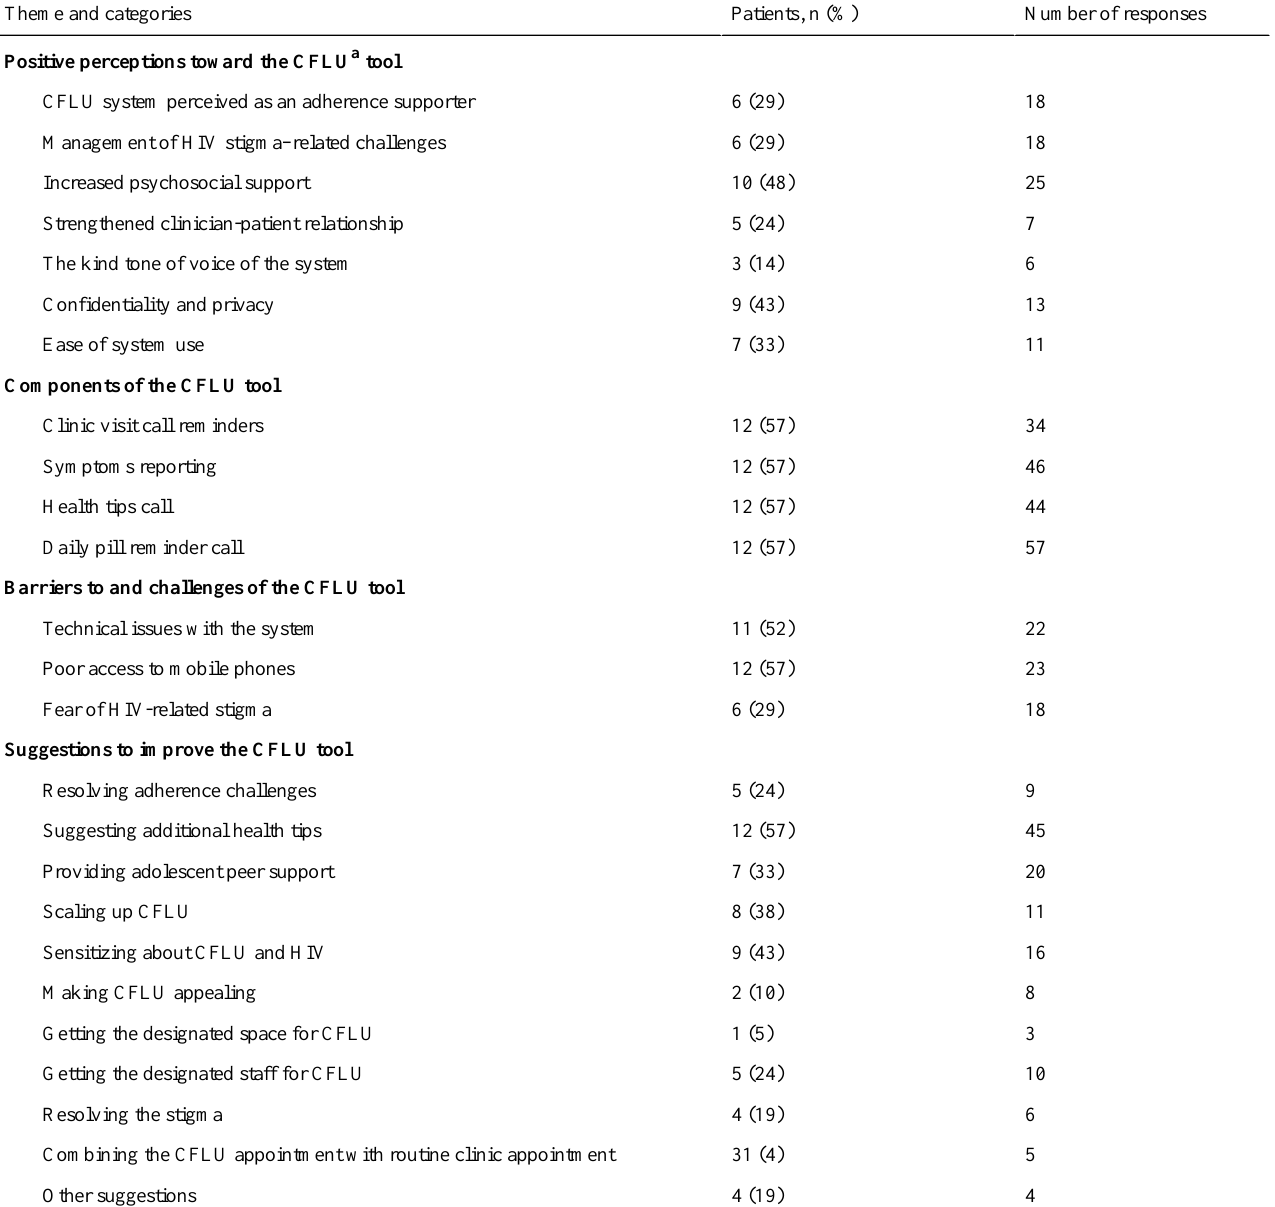
Number of responsesPatients, n (%)Theme and categories